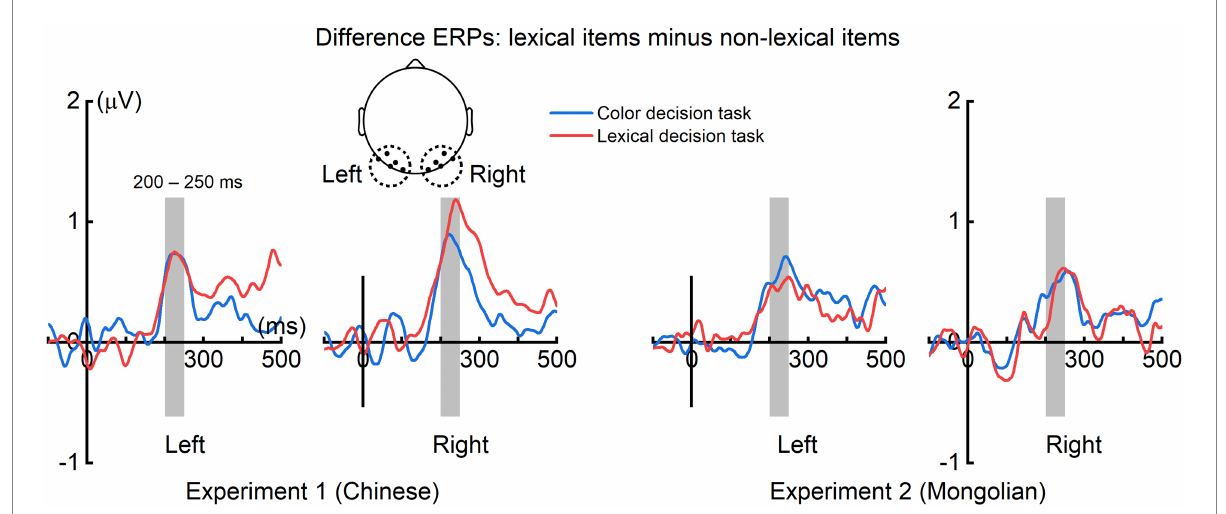
FIGURE 5 Difference ERPs in the left and right scalp regions. For both tasks and both experiments, prominent difference ERPs (obtained by subtracting the ERPs of lexical items from the ERPs of non-lexical items) were observed at approximately 200–250 ms in the left and right scalp regions.